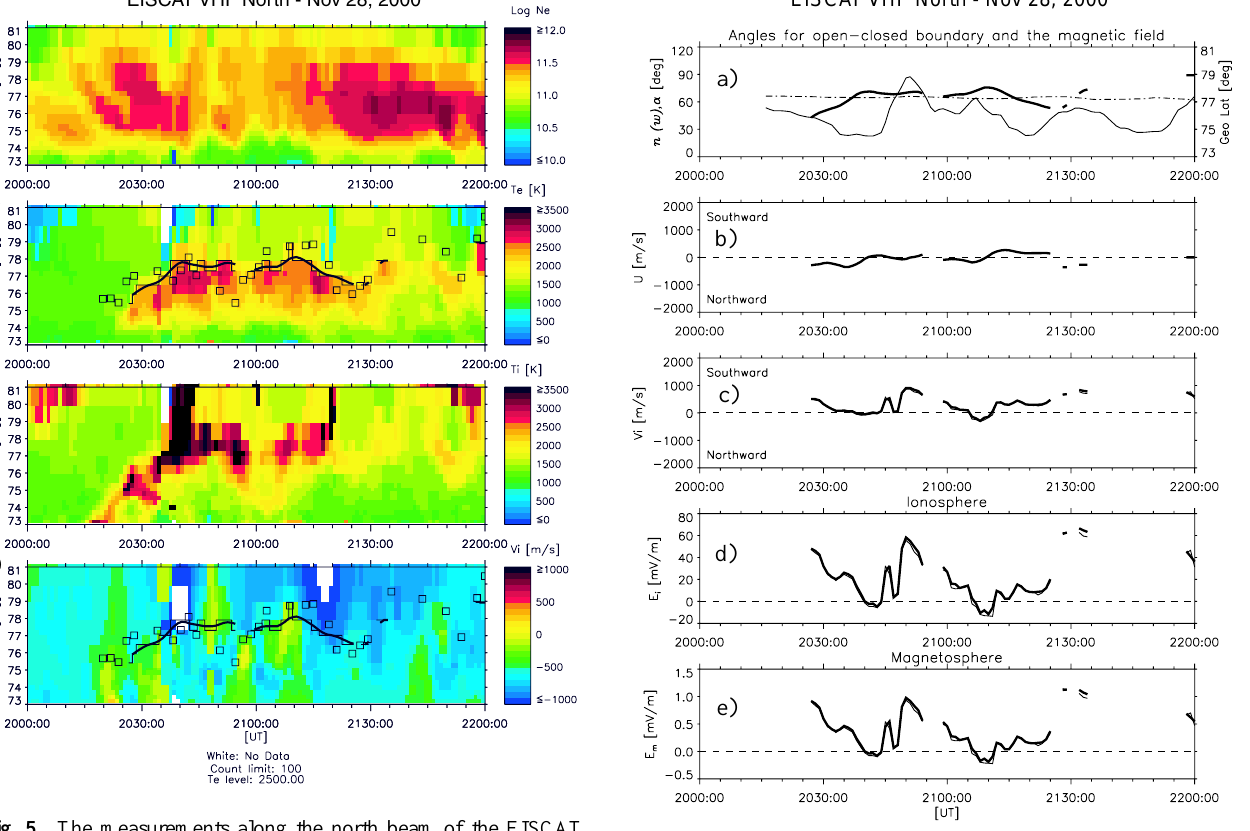
Fig. 6. The reconnection rate estimated from the north beam: ( a ) Thick line: the smoothed geographic latitude of the open-closed boundary, thin line: the angle, n , between the open-closed boundary and the line-of-sight and dashed-dotted line: the angle α , between the magnetic field and the line-of-sight. ( b ) The smoothed boundary velocity, u Eq. (10) ( c ) Thin line: the maximum ion flow velocity, v , Eq. (8) in the gate position defining the open-closed boundary (thin line in Fig. 5d) and thick line: The maximum ion flow velocity when the average of three gate positions are used ( d ) . The iono- spheric projection of the reconnection electric field (Eq. (6) using one v value (thin) and the average of three v -values (thick). ( e ) The reconnection electric field in the magnetosphere (Eq.